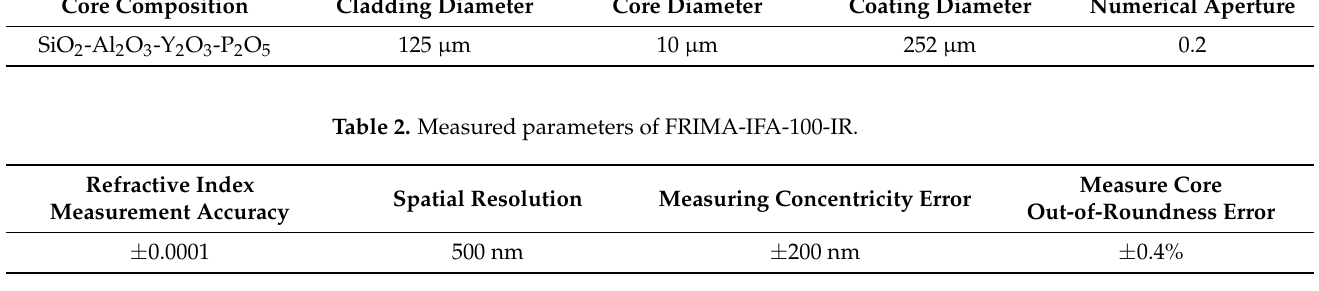
Table 2. Measured parameters of FRIMA-IFA-100-IR.